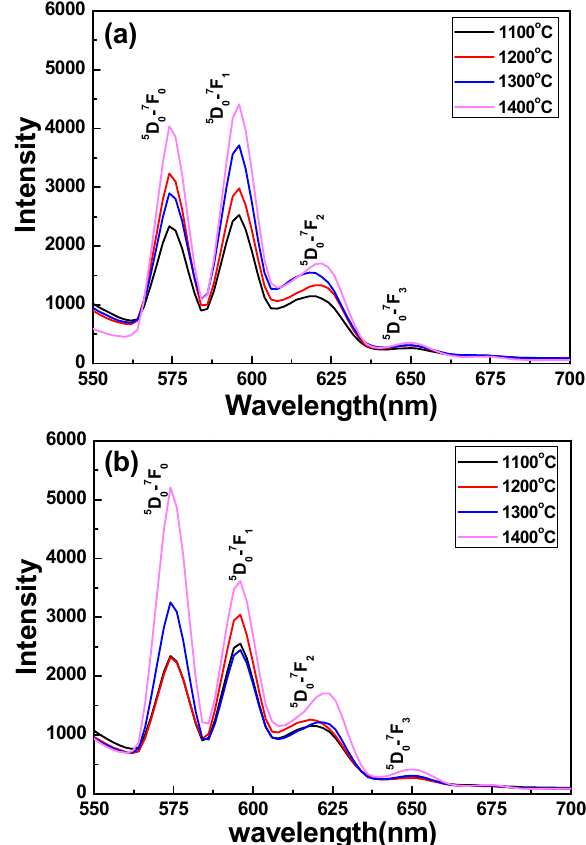
Figure 4. Emission spectrum of BaZrO 3 :Eu 0.025 powders in the light wavelength of 550–700 nm as a function of heating process and heating temperature. ( a ) One-step Eu-BZO powders and ( b ) Two-step Eu-BZO powders, respectively.